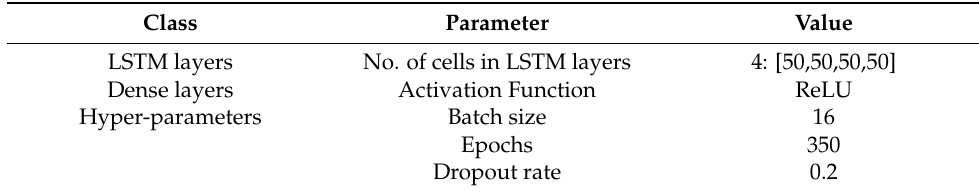
Table 6. Parameter settings for the LSTM